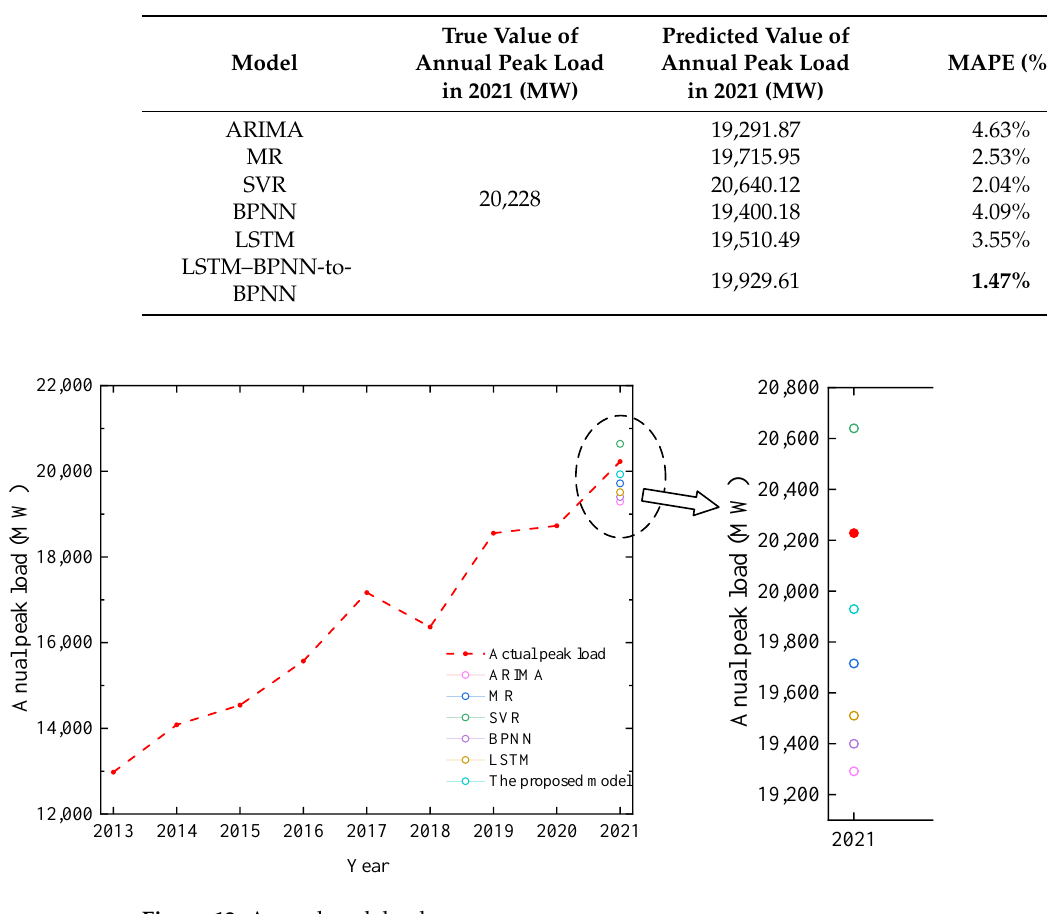
Figure 12. Annual peak load curve. Table 8. Comparison of predictive performance of six models in the forecasting annual peak load in 2021.